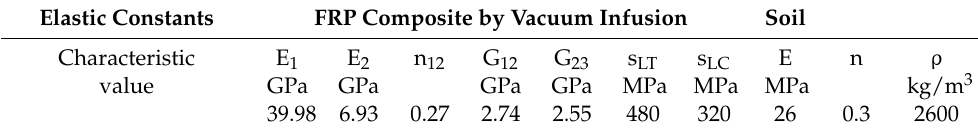
Table 2. Considered characteristic material properties of the FRP composite [26] and the soil in the study. Elastic